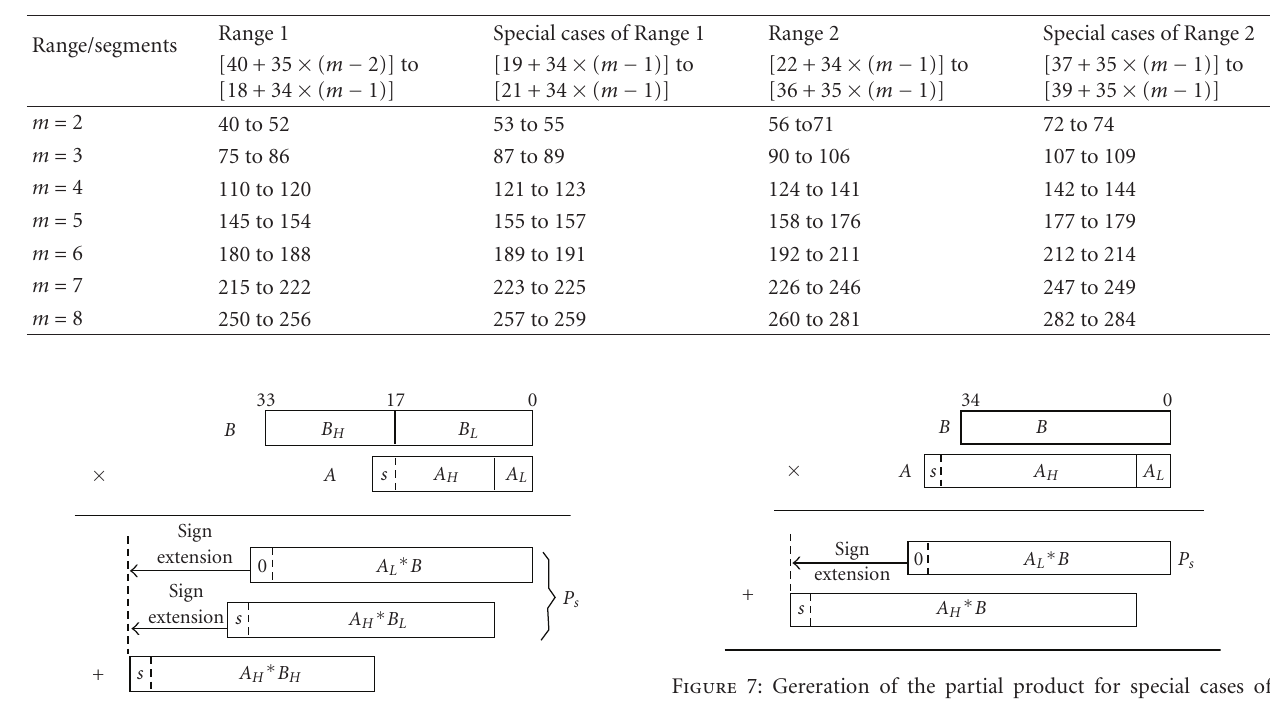
Table 2: The ranges of input bit size with special cases for decompositions.